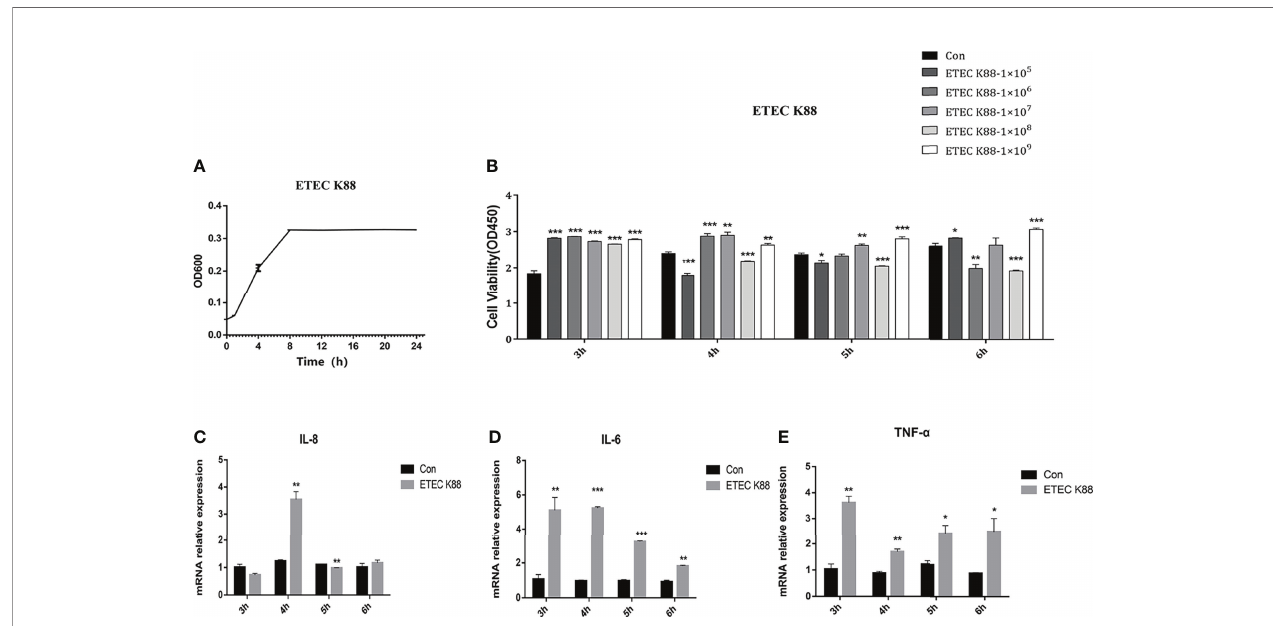
FIGURE 2 | Effects of ETEC K88 on cell viability and in fl ammatory cytokine expression in IPEC-J2 cells. (A) The growth curve of ETEC K88. (B) The effects of different levels of ETEC K88 on the viability of IPEC-J2 treated for 3 h, 4 h, 5 h, and 6 h. (C) The relative gene expression of IL-8 after being treated with 1 × 10 8 cfu/ ml ETEC K88 for 3 h, 4 h, 5 h, and 6 h. (D) The relative gene expression of IL-6 after being treated with 1 × 10 8 cfu/ml L. reuteri LR1 for 3 h, 4 h, 5 h, and 6 h. (E) The relative gene expression of TNF- a after being treated with 1 × 10 8 cfu/ml L. reuteri LR1 for 3 h, 4 h, 5 h, and 6 h. Data presented as mean ± SEM ( n ≥ 3). * p < 0.05,** p < 0.01, and *** p < 0.001 vs. the control